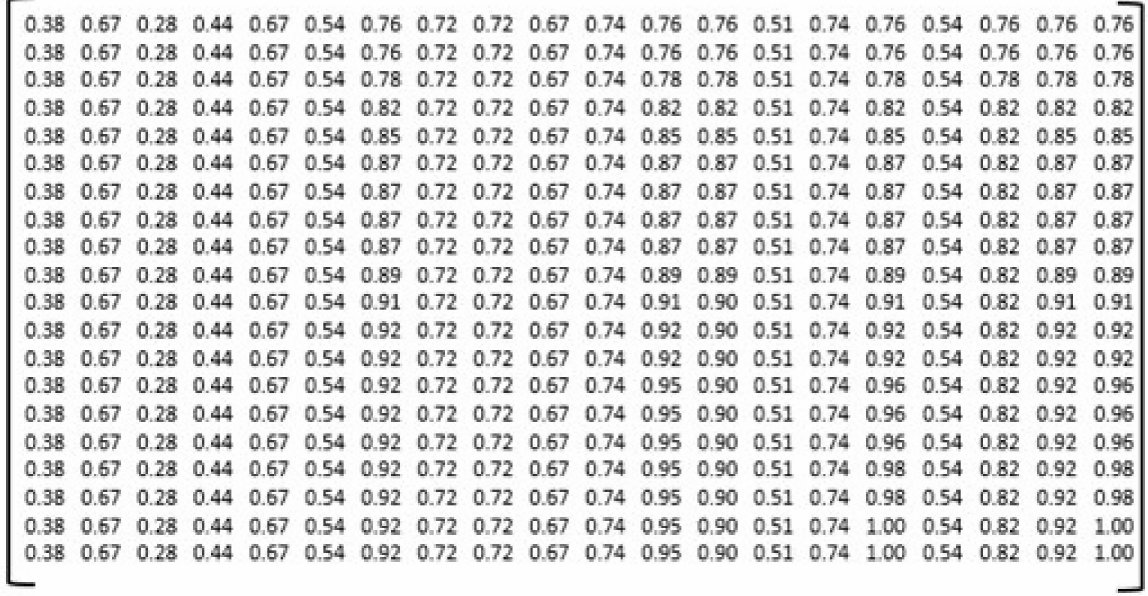
Figure 7. The fuzzy set transformer matrix FTM (the production rule) for the main